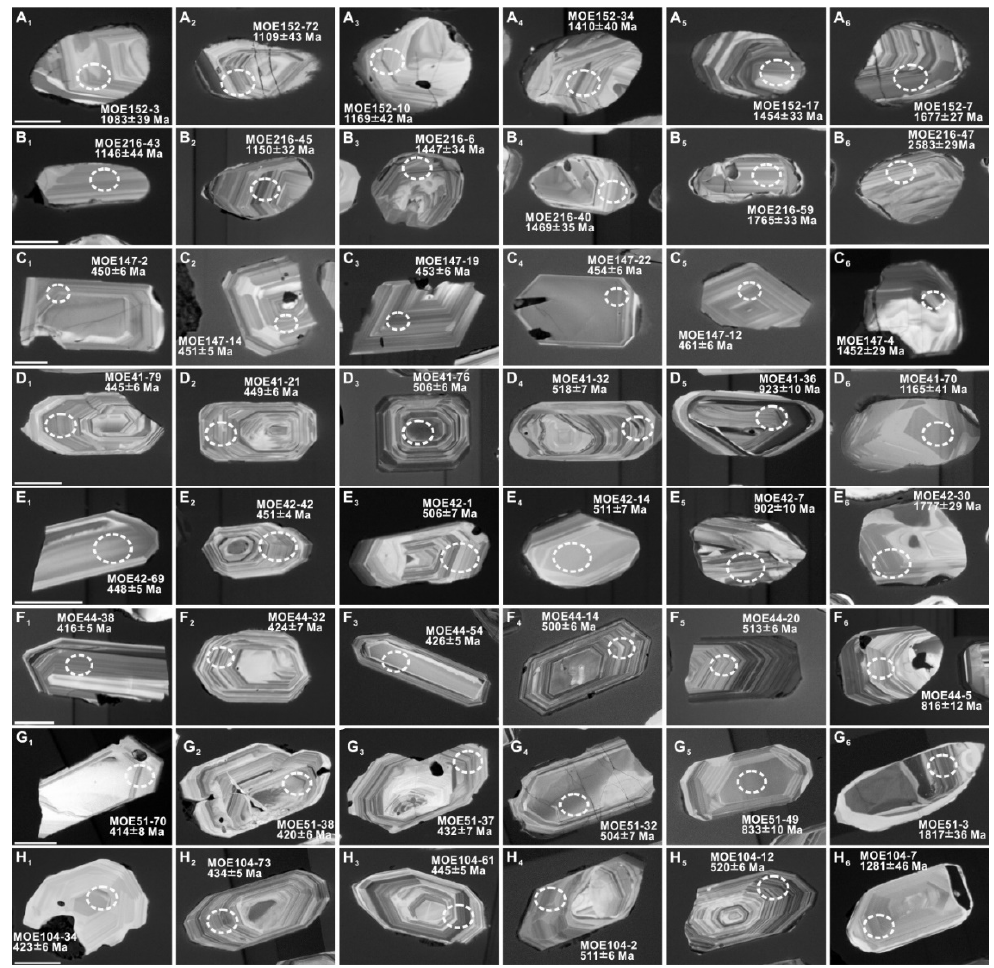
Figure 6. Representative cathode luminescence (CL) images of zircon grains of the dated samples from the Ereendavaa terrane in NE Mongolia. Also shown are approximate positions, numbers and apparent ages of the analytical spots (open circles of dashed line). Each raw image is for representative zircon grains from one sample; ( A – H) are for samples MOE-152, MOE-216, MOE-147, MOE-41, MOE-42, MOE-44, MOE-51, and MOE-104, respectively. The analytical spot names are the same as those in Table S1. All scale bars are 50 μ m long (please note that the scale bar for each panel in one raw image is the same and so it is just shown in the leftmost panel of each raw image).